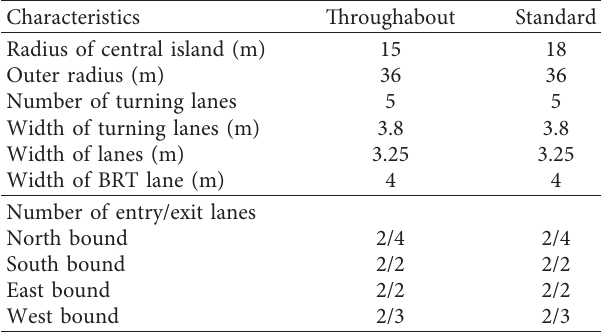
Table 1: Geometric properties of the studied